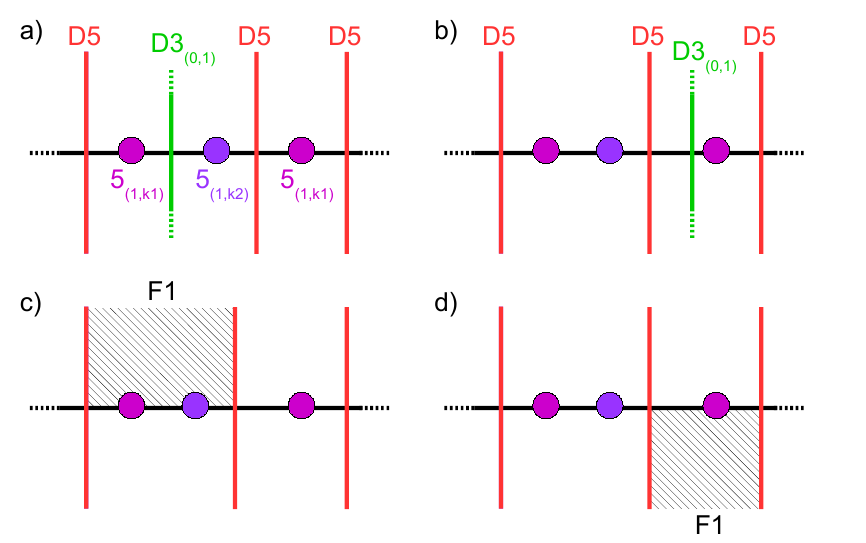
Figure 28 . Setups realizing the insertion of the branch III operators: (a) X III; 1 , (b) X III; 2 , (c) Z + , (d) (cid:0) Z (cid:0) . Only the relevant part of the brane setup is shown (in the x 34 [12] [23]